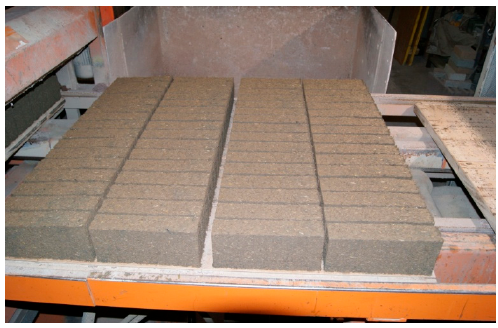
Figure 4. A set of blocks placed for curing.